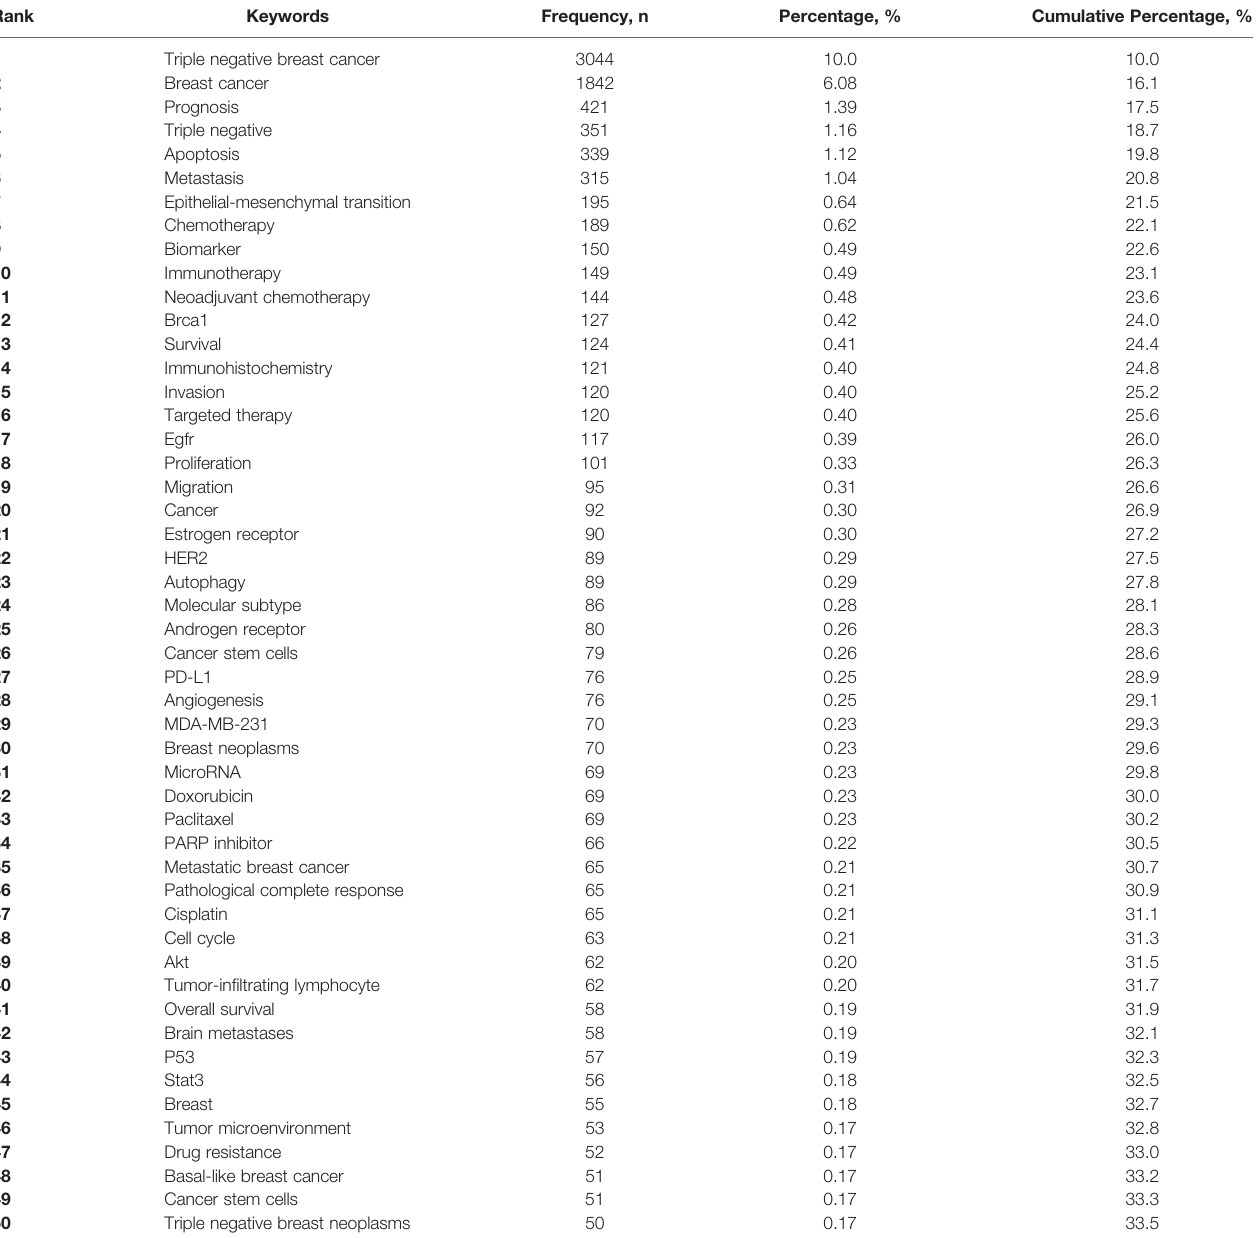
TABLE 3 | High-frequency Keywords in the TNBC